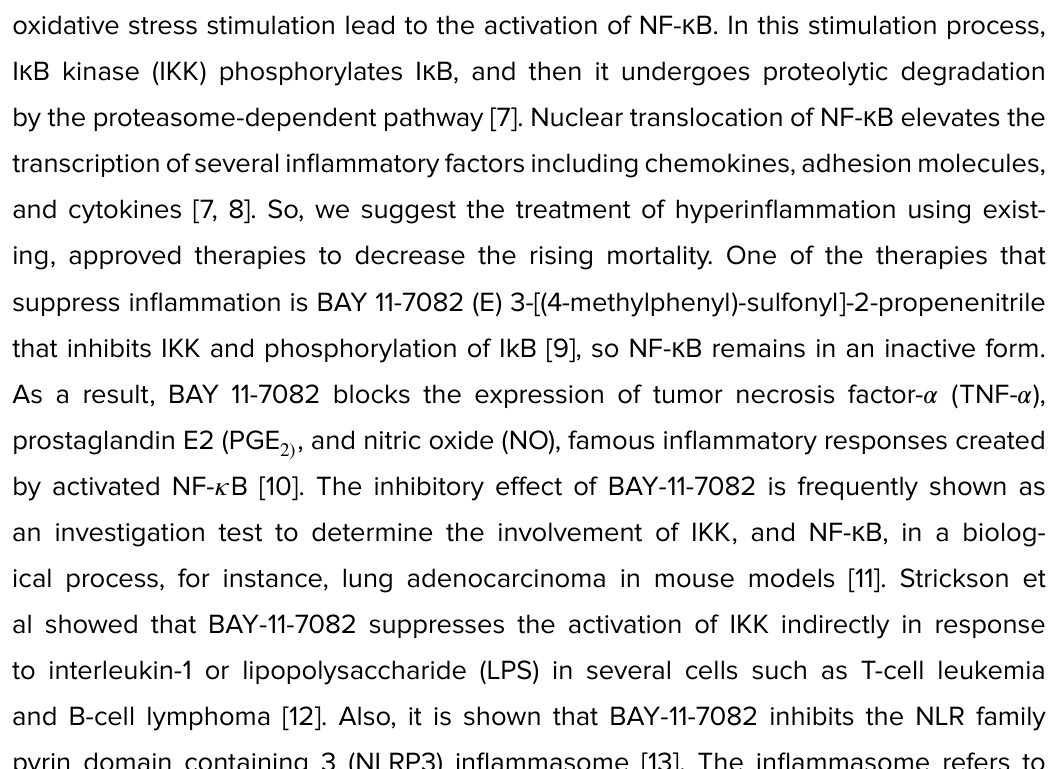
Figure 1 : Anti-inflammatory effect of BAY 11-7082 on